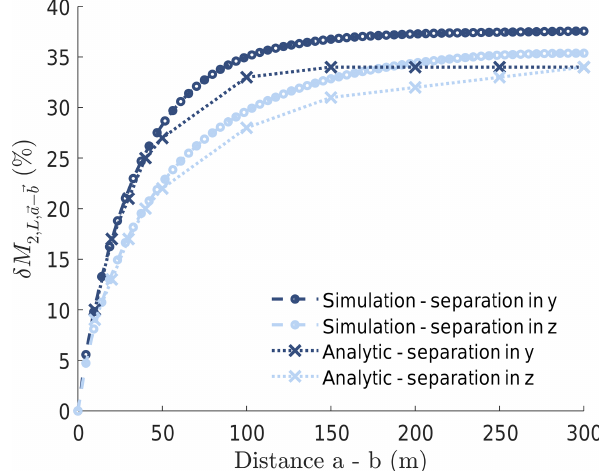
Figure 1. Simulation-based validation of analytical calculation of spatial variance of the second-order moment of ABL wind flow. Comparison is conducted for the second-order moment of axial wind speed u for spatial separation of two points in the cross-axial and vertical